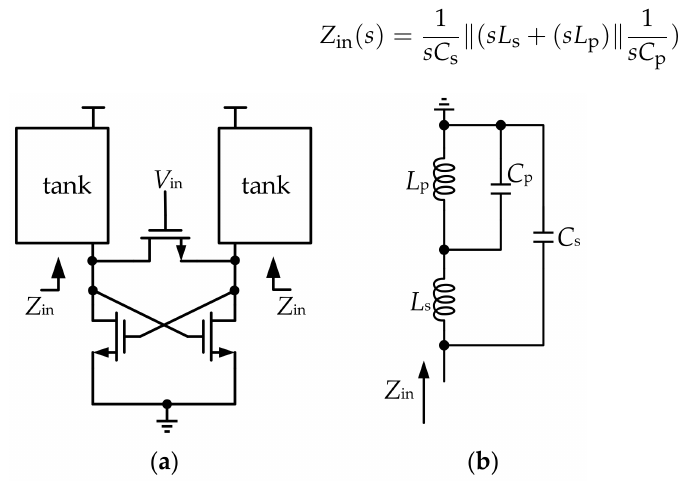
Figure 2. ( a ) Conceptual diagram of the proposed ILFD. ( b ) AC equivalent circuit of the tank (losses of the inductors and capacitors not